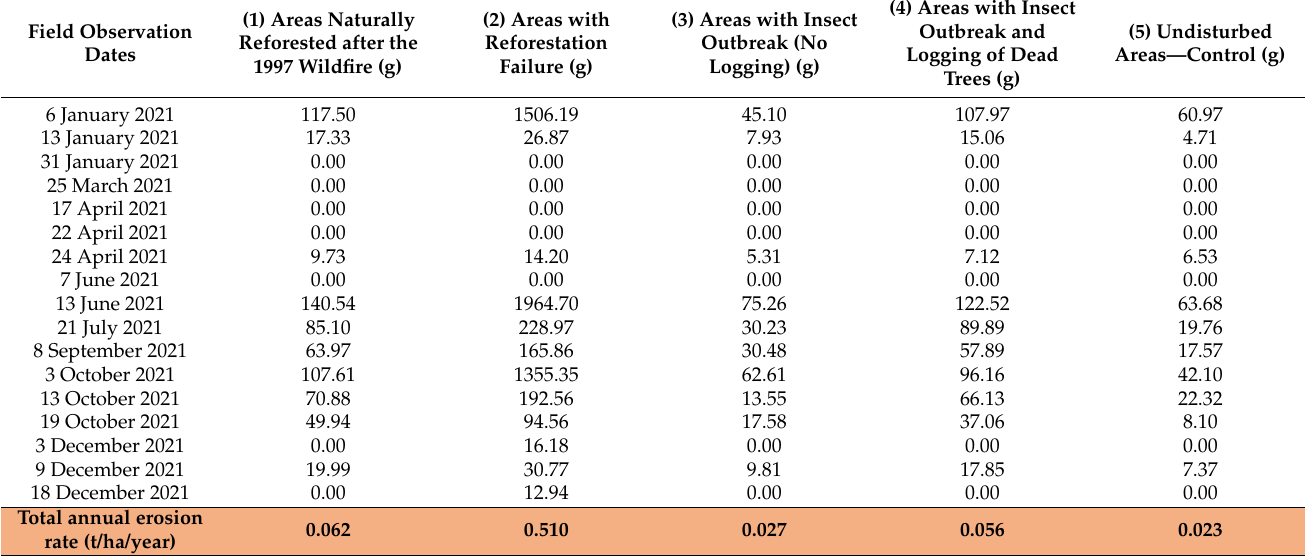
Table 2. Soil erosion values (in grams) of the year 2021 for each case and rainfall event. In the last row, the total annual erosion rate (t/ha/year) for each examined case is